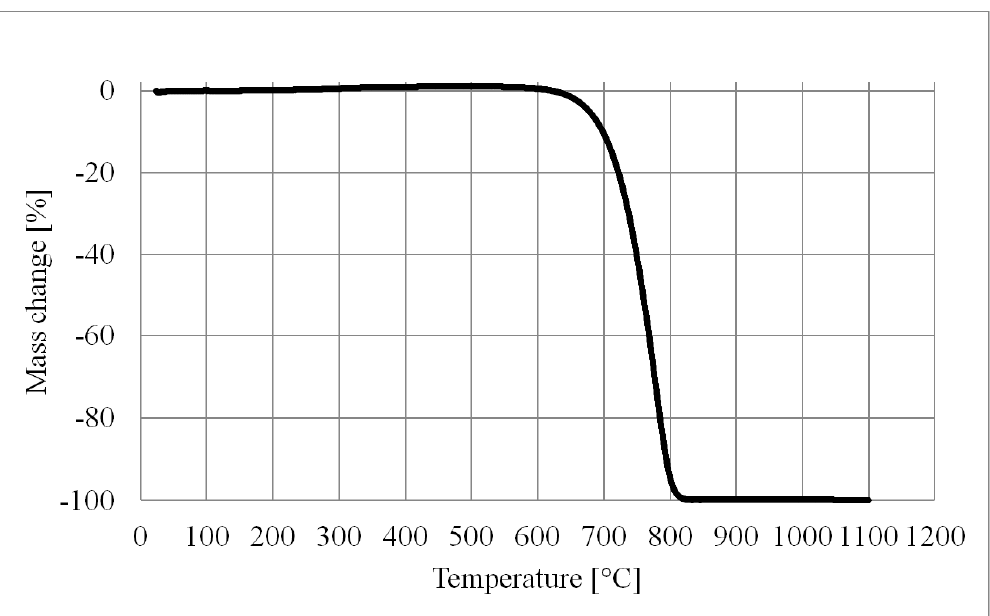
Figure 6. Thermogravimetric analysis with pure graphite powder in air, heating rate 5 K/min.